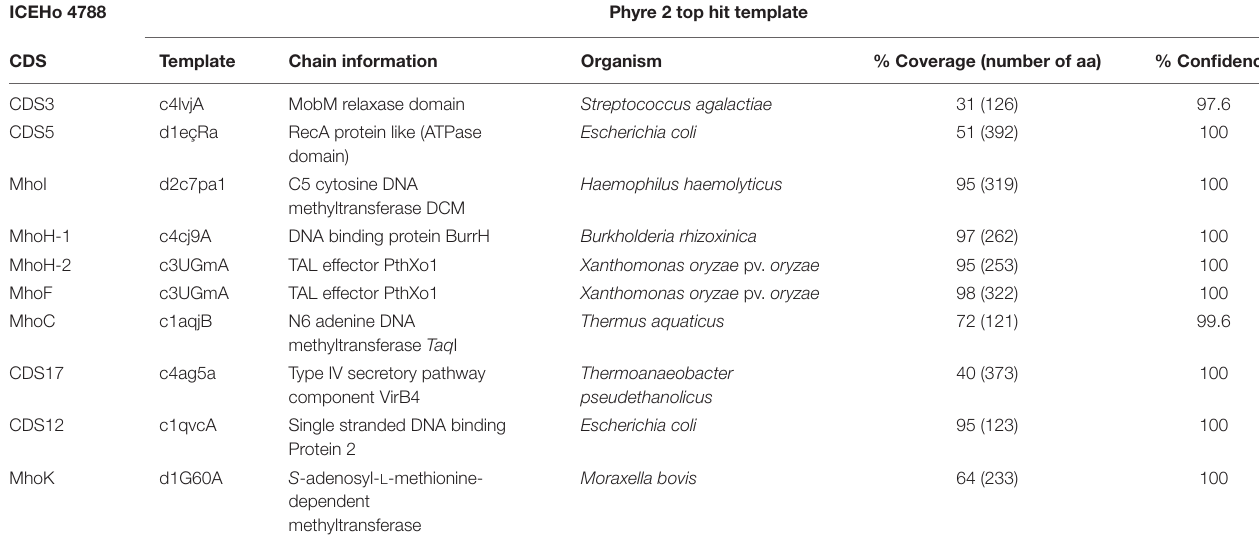
TABLE 5 | Phyre2 models for ICEHo 4788